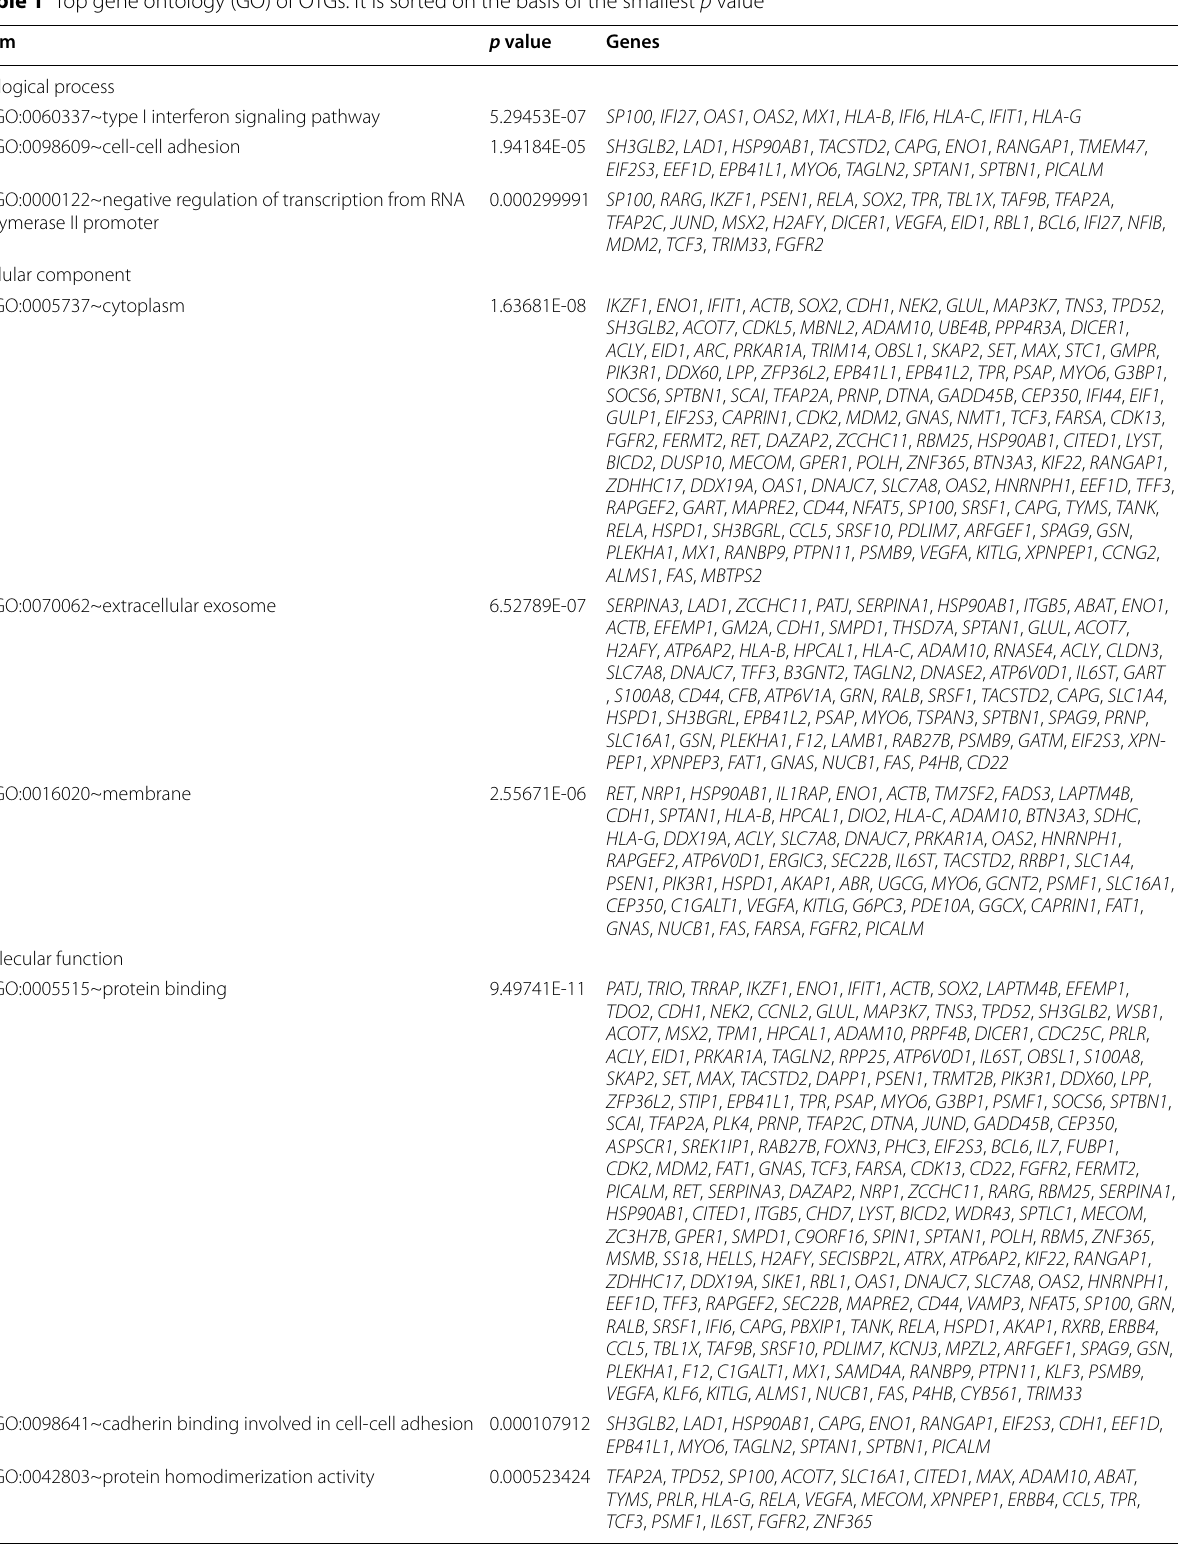
Table 1 Top gene ontology (GO) of OTGs. It is sorted on the basis of the smallest p